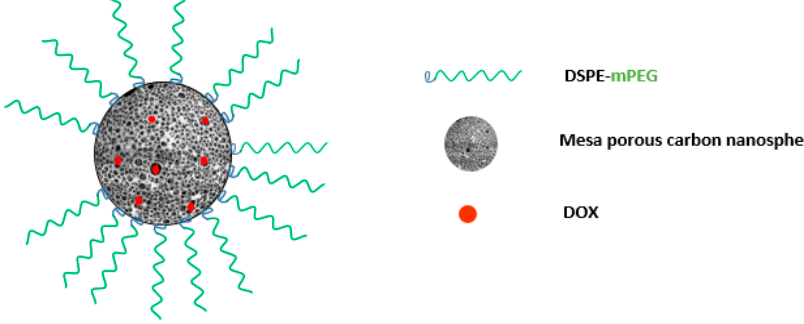
Figure 14. D oxorubicin hydrochloride (DOX)/MCN-PEG nanoparticulate design. Figure 14. Doxorubicin hydrochloride (DOX) / MCN-PEG nanoparticulate